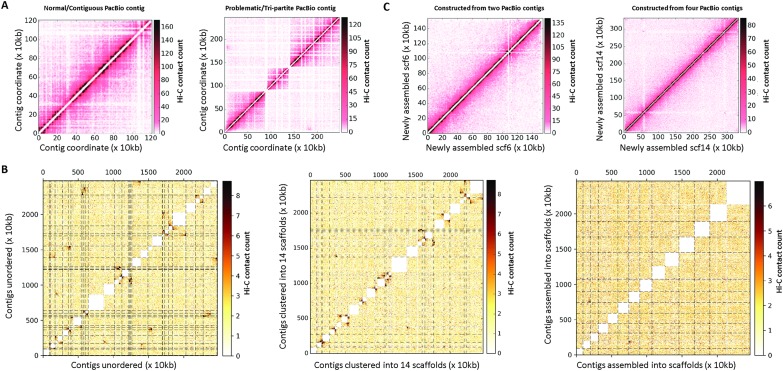
Hi-C assisted scaffolding of PacBio contigs. (A) Alignment of Hi-C data to the
initial set of 35 high-coverage contigs by PacBio assembly showed that one of the
contigs includes DNA from three different chromosomes as evidenced by the
tri-partite structure of intracontig contact map of this contig (right). Other
contigs did not exhibit similar contact patterns (representative example – left)
suggesting they are contiguous pieces from a single chromosome. (B) Intercontig Hi-C
contact maps of the unordered set of contigs (left) that were named according to
their similarity with chromosomes in the PKNH assembly show striking off-diagonal
contact enrichment suggesting that pairs of contigs that belong to the same
chromosome are not ordered consecutively. Similar intercontig maps when contigs are
clustered into scaffolds according to their Hi-C contact counts (mid) show minimal
off-diagonal enrichment. Interchromosomal/scaffold contact map generated by aligning
Hi-C reads to the new, chromosome level assembly (right) exhibits contact patterns
that are expected of and observed in Plasmodium and yeast species
(Ay et al.
2014b; Duan et al.
2010). This assembly was generated by
breaking down the problematic contig, clustering contigs into chromosomal groups,
and ordering and reorienting contigs within each group to maximize Hi-C contacts
between adjacent and correctly oriented contigs to create scaffolds representative
of each chromosome. (C) Intrascaffold Hi-C contact maps (normalized counts, 10 kb
resolution) from two representative scaffolds in the new assembly. Scaffold 6 (left)
and scaffold 14 were constructed by joining two and four PacBio contigs,
respectively. The rows/columns marked by white represent unmappable or poorly
mappable regions with Hi-C reads (Illumina 76 × 2 bp, paired-end sequencing).